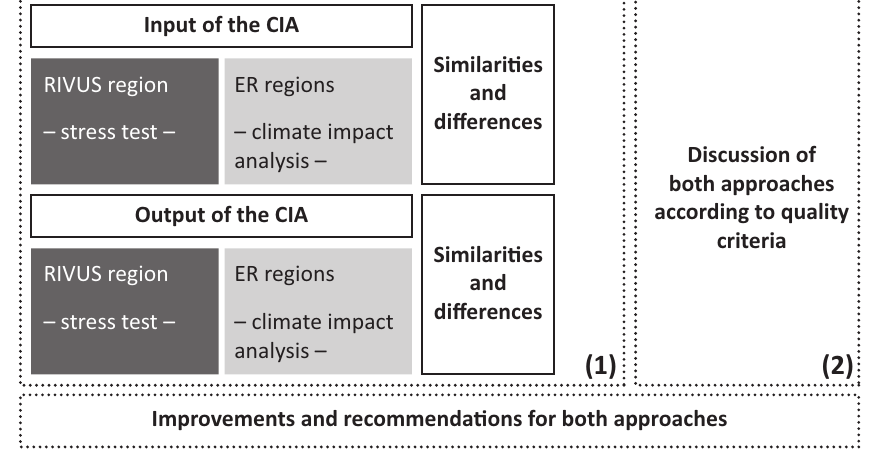
Figure 2. Methodological approach of the international comparative research. ment of stakeholders will be considered (see Table 1).